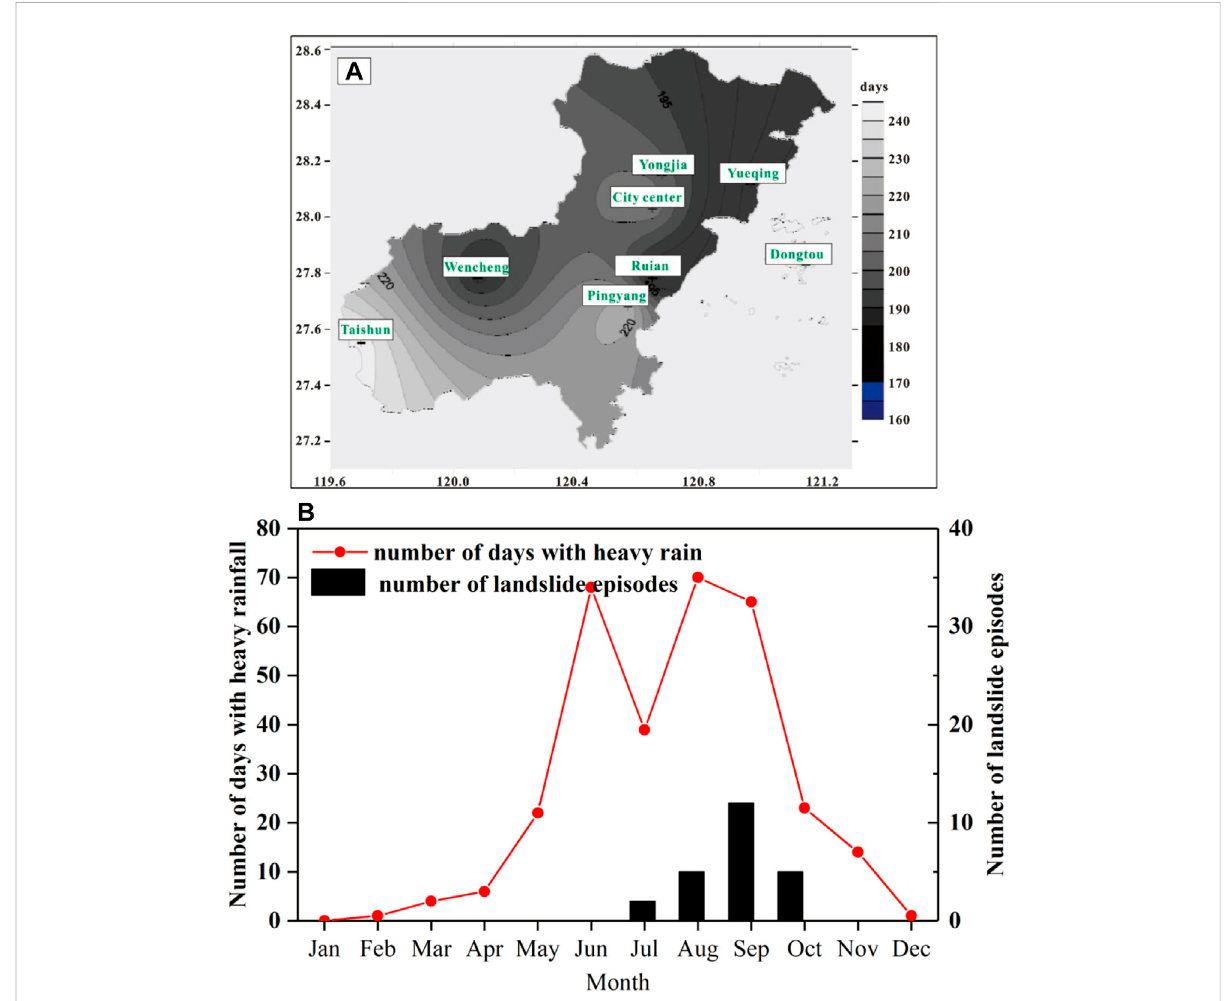
FIGURE 3 Relationshipbetweenlandslidesandrainfallinthestudyarea: (A) spatialdistributionofthenumberofdayswithheavyrainfalleventsduring1972 and 2013inWenzhouCity,and (B) relationship betweenthenumber ofdays with heavy rainfall andthenumberof landslide episodesineach month.